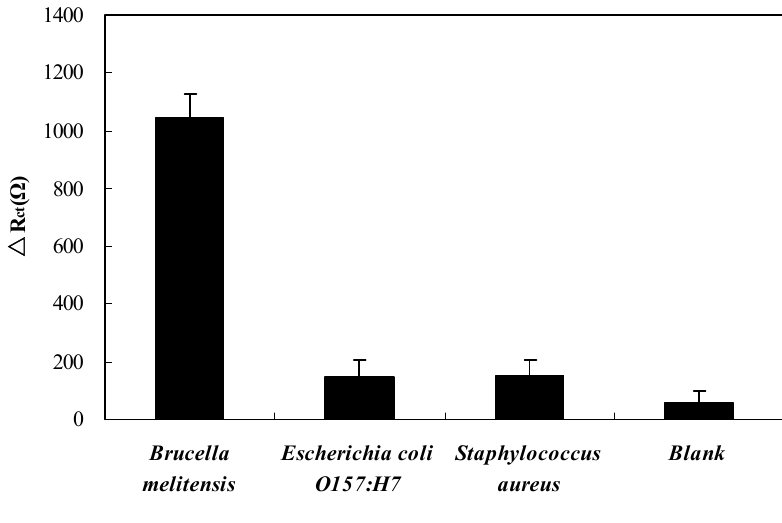
Figure 6. Specificity of the GNP-SPCE immunosenor for Brucella melitensis